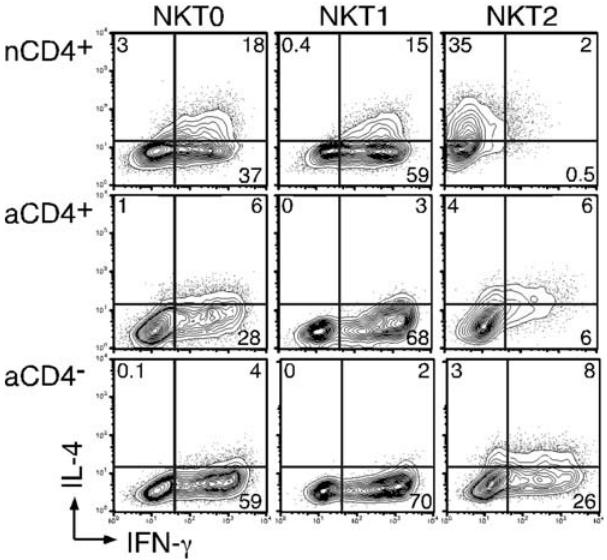
Figure 2. Cytokine polarization of NKT cell subsets. Neonatal or adult NKT cells were purified and activated under conventional Th0 (medium alone; NKT0), Th1 (NKT1), or Th2 (NKT2) polarizing conditions as described in the methods and expanded in IL-2-containing media. These cells were re-stimulated for 6–8 hours using DCs pulsed with a - GalCer (100 ng/ml), or alternatively, anti-CD3 and anti-CD28, in